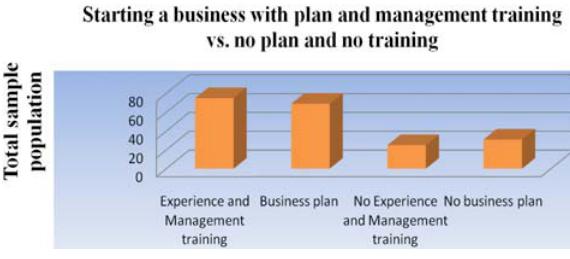
Fig. 3. Business plan and management training vs.